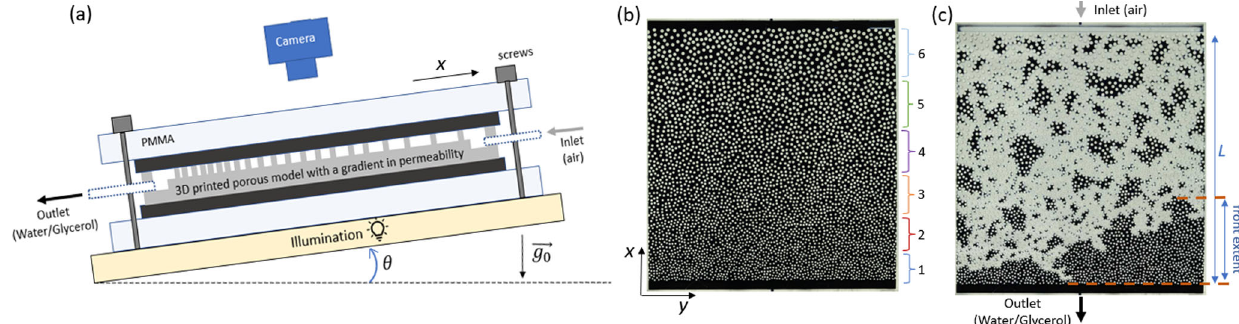
Fig. 1 Experimental set-up. a Schematic cross-section of the experimental set-up. Two transparent PMMA plates (3 cm thick) are screwed together to close the 3D printed porous model with a gradient in grain and pore-throat sizes. Soft polymer layers (black layers) ensure good contacts between the PMMA plates and the model. The model is illuminated from below and pictures are taken from above. b , c Top-view pictures. Photographs of a non-wetting fl uid (air) invading a wetting fl uid (water-glycerol) in the square porous model of coordinate system ( x , y ). The side of the model is L = 140 mm. A pump is connected to the outlet and the inlet is open to air. The model can be tilted, leading to a capillary pressure gradient G ¼ Δ ρ g 0 sin ð θ Þ in the x direction, where g 0 = 9.82 m s − 2 and Δ ρ ~ 1200 kg m − 3 is the difference of density between the wetting and non-wetting fl uids. The full-extent width of the invasion front highlighted in c and, to better characterise the average front width, we will denote by η the standard deviation of the front position along x .